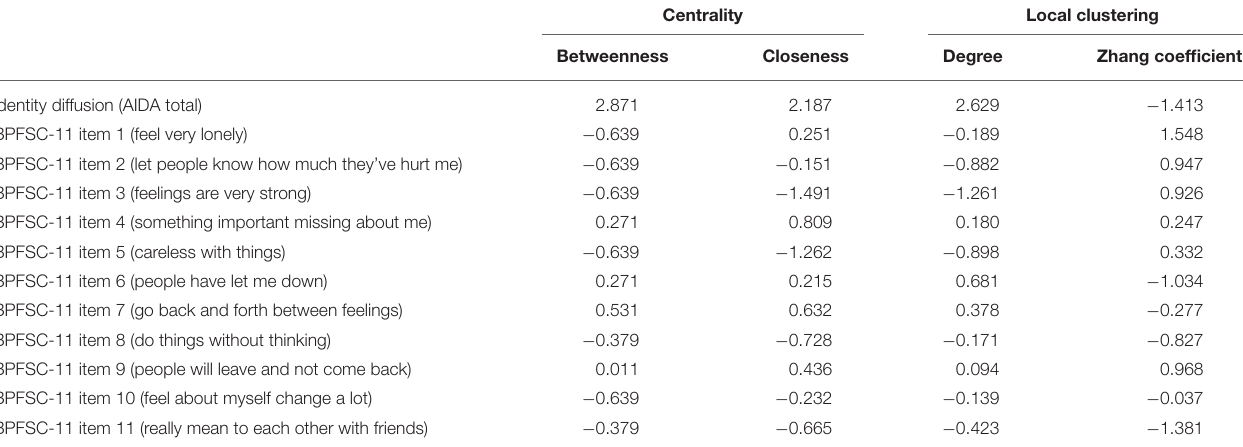
TABLE 2 | Characteristic parameters of the network’s nodes; centrality and local clustering coefficients (all coefficients are standardized